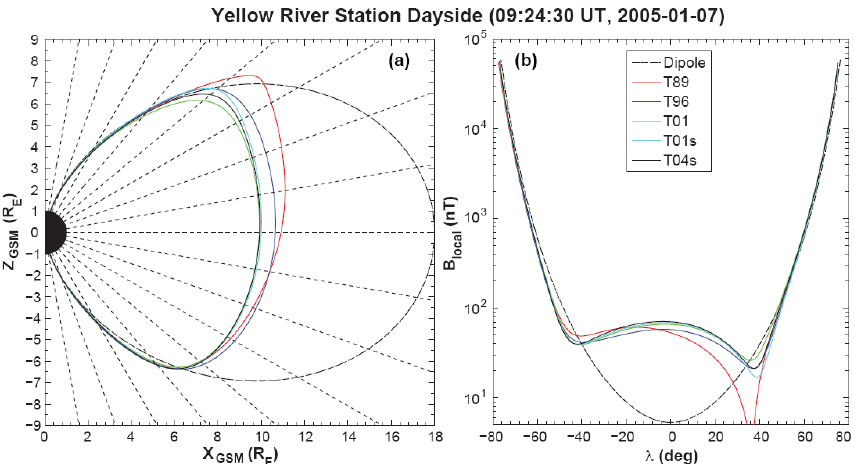
Fig. 4. (a) Modeled magnetic field configuration and (b) magnetic field amplitude along the field line corresponding to the YRS location for Figure 4 . (a) Modeled magnetic field configuration and (b) magnetic field amplitude 613 the event at 09:24:30UT on 7 January 2005, color coded for the six specified magnetic field models. Figure 5. 627 along the field line corresponding to the YRS location for the event at 09:24:30 UT on 614 January 7, 2005, color coded for the six specified magnetic field models. 615